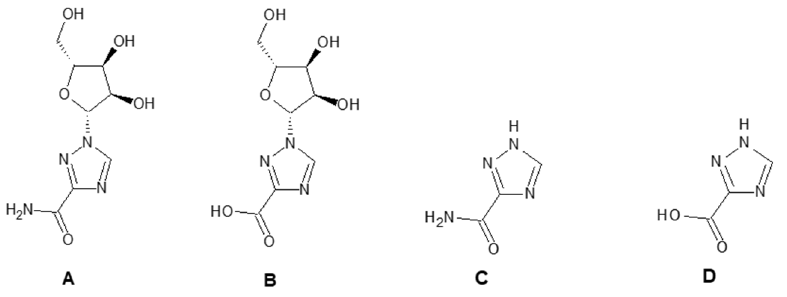
Figure 1. RBV and its metabolites. A : RBV; B : TR-COOH; C : T-CONH 2 ; D : T-COOH.